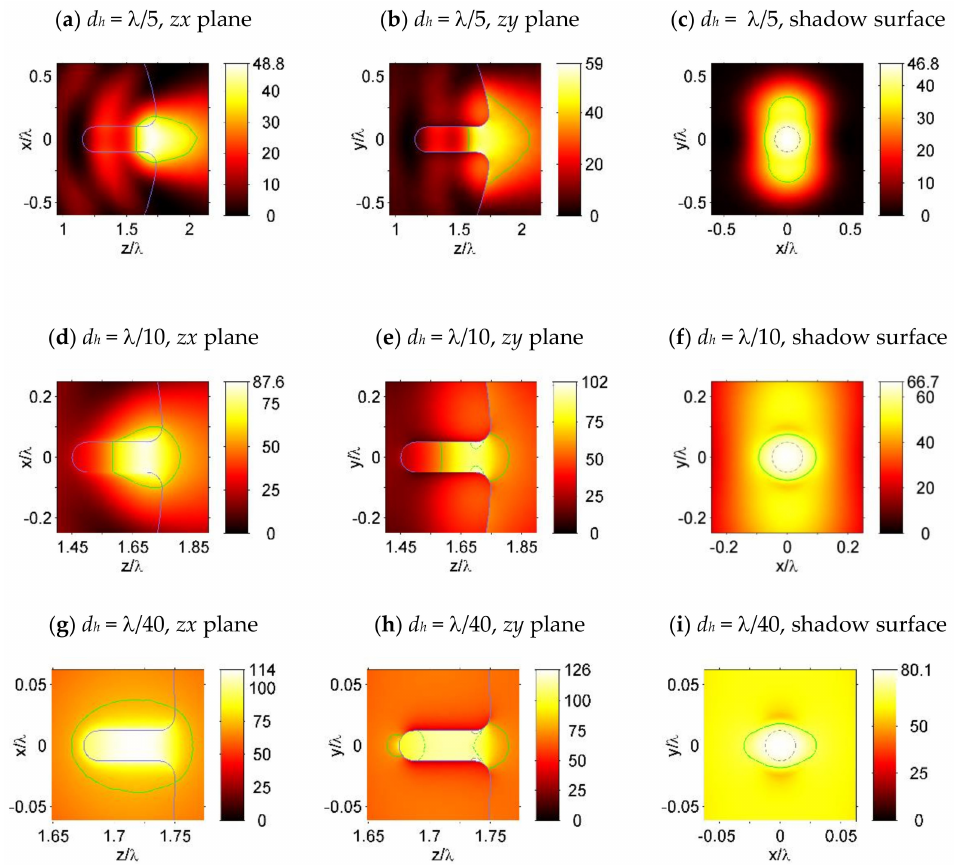
Figure 4. Light intensity (|E| 2 ) of the simulated dielectric microspheres with a blind nanohole of the diameter ( a – c ) d h = λ /10, ( d – f ) d h = λ /10, and ( g – i ) d h = λ /40. The sphere diameter and refractive index are set as D s = 3.5 λ and n = 1.5, with a hole depth of 3 d h . Subfigures ( a , d , g ) are plotted in the zx-plane, which is perpendicular to the polarization plane. Subfigures ( b , e , h ) are plotted in the zy-plane, which is the polarization plane. To indicate the “hot spots” in subfigures ( e , h , i ), contour lines at the value of 0.5 I max , 0.85 I max , and 0.9 I max are plotted by the green solid lines, the green dashed lines, and the gray solid lines, respectively. Subfigures ( c , f , i ) show the light intensity along a plane that is 0.001 λ from the shadow surface of the sphere and the circles, which are plotted by gray dashed lines, indicating the projection of the hole interface in the shadow